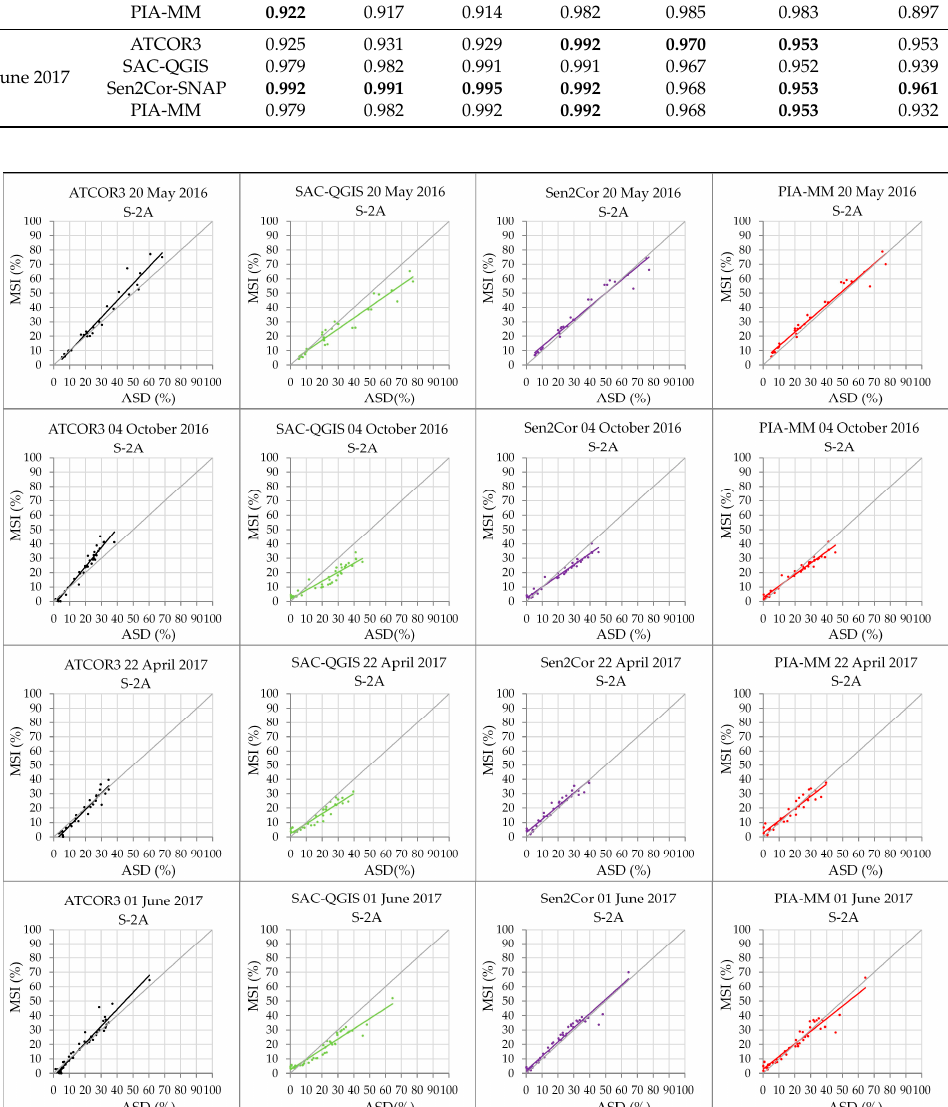
Figure 10. Scatterplots of the correlation between field measurements ( X axis) and the values of its corresponding pixel in each Sentinel-2 atmospheric correction method ( Y axis) accounting for all the bands (last column in Table 5).